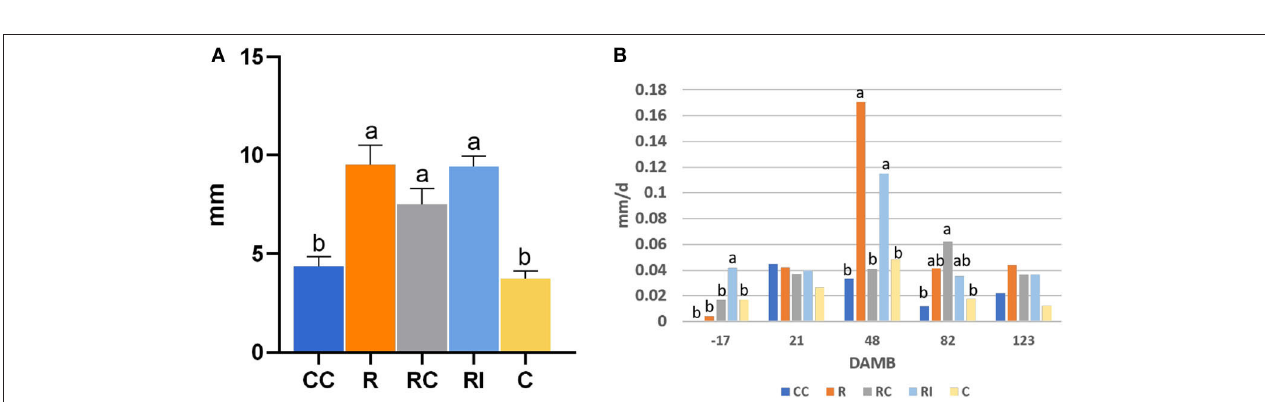
FIGURE 1 | Qualitative scoring of KEDS symptoms in kiwifruit plants at different days after mid bloom (DAMB). C, Control; CC, Control + Compost; R, Ridged; RC, Ridged + Compost; RI, Ridged + Inoculum.